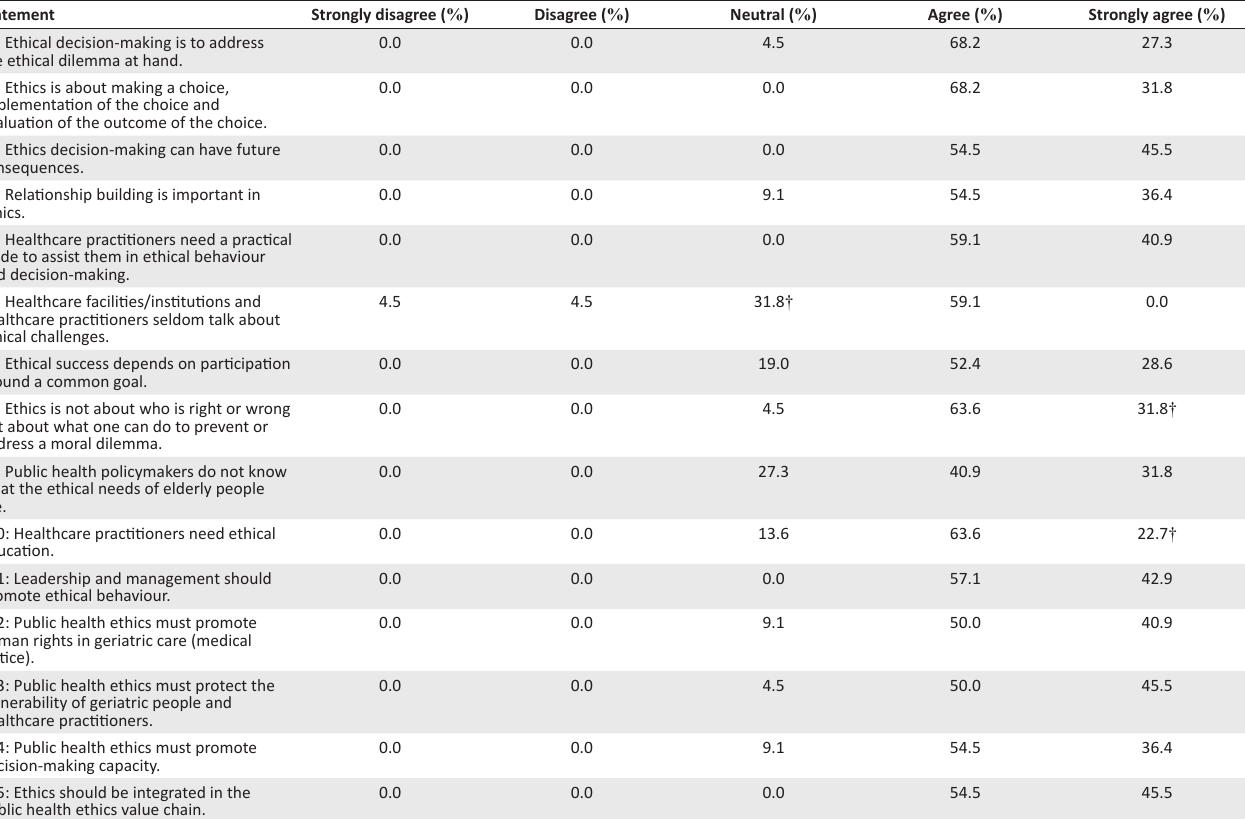
TABLE 3: Statements around a public health ethics